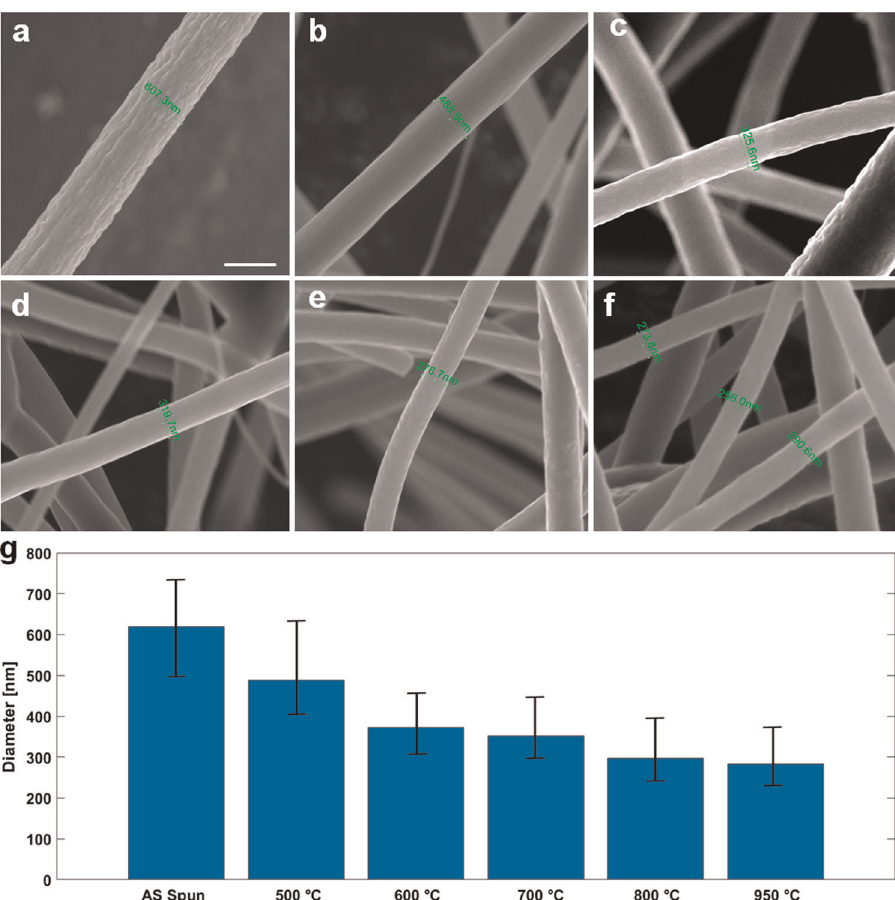
Fig. 1 FESEM images showing the diameter evolution of individual nano fi bers of a as-spun PAN nano fi ber bundle and nano fi ber bundle pyrolyzed at b 500 °C, c 600 °C, d 700 °C, e 800 °C, f 950 °C. g Bar graph demonstrating the overall decrease in nano fi ber diameter with error bars depicting standard deviation. Scale bars ( a – f ) = 500